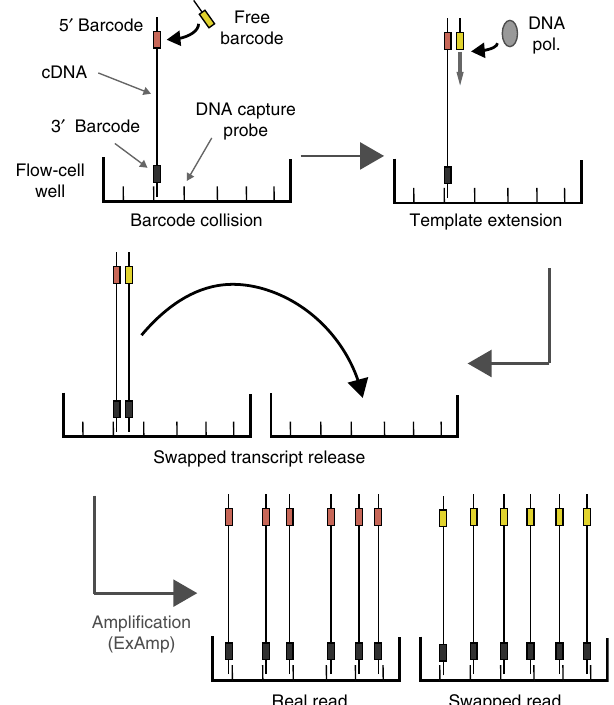
Fig. 1 A schematic of the mechanism for barcode swapping, as proposed by Sinha et al. 1 . On new models of the Illumina sequencing machines, fl ow cell seeding and DNA ampli fi cation take place simultaneously, without any washes of the fl ow cell between steps. As a result, free sample indexing barcodes remain in solution and can be inadvertently extended using DNA molecules from libraries with different barcodes as templates. The transfer of mislabelled molecules between nanowells of the fl ow cell results in clustering and sequencing of incorrectly labelled DNA